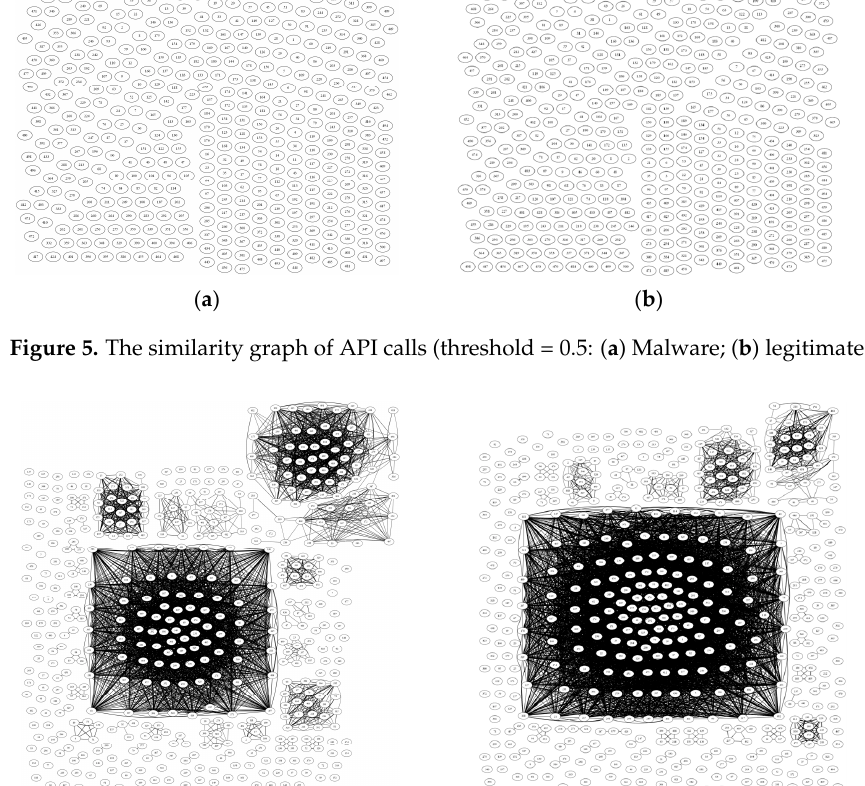
Figure 7. The similarity graph of full API call sequences of malware samples (threshold = 0.5). Achieving strong correlation requires extraction of the full API call sequences. How- ever, extracting the first 100 non-consecutive repeated API calls still provides valuable correlation. Therefore, this work proposes to follow the same methodology as [36], which depends on the first 100 API calls but uses the number of occurrences of each API call instead of API call sequences. Traditional machine learning algorithms are then used in- stead of deep learning solutions. 7. Malware Detection Using the Frequency of API Calls The workflow in this section is depicted in Figure 8. In the public domain data set [42], the API call sequences were gathered by running each sample on Cuckoo Sandbox. These sequences were only extracted from the parent process, since malware detection requires that malicious behaviour be recognised as early as possible. Additionally, only the first 100 API calls were taken into account. After these processes, the list containing unique API calls was created. In the final step, a unique integer number was given for each API call according to its index in the list. As stated in Section 4, the number of distinct